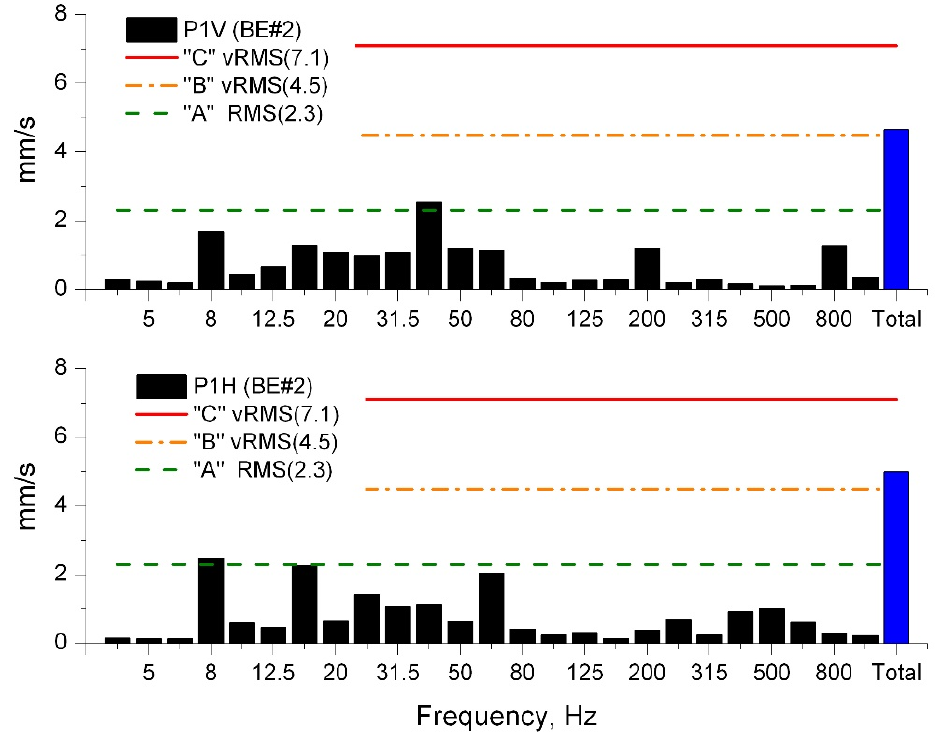
Figure 11. Typical spectrum of the RMS vibration velocity at point P1 in bucket elevator BE#2: in the vertical direction ( top ) and in the horizontal direction ( bottom ). The column with the total value is marked in blue.